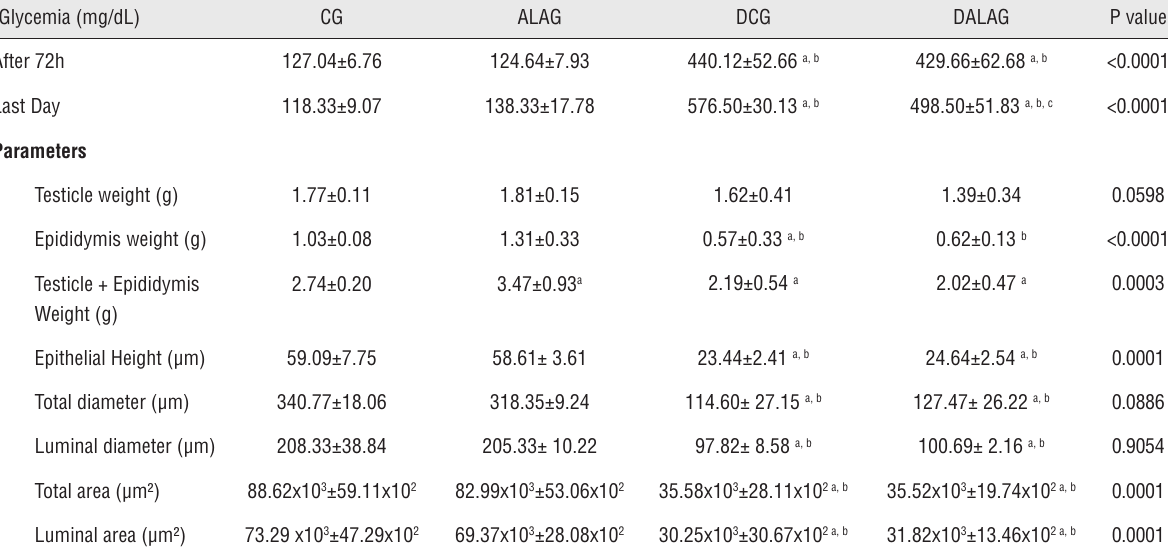
Table 2 – Glycemia, biometric of the testes and epididymis and histomorphometric analysis of the seminiferous tubules.